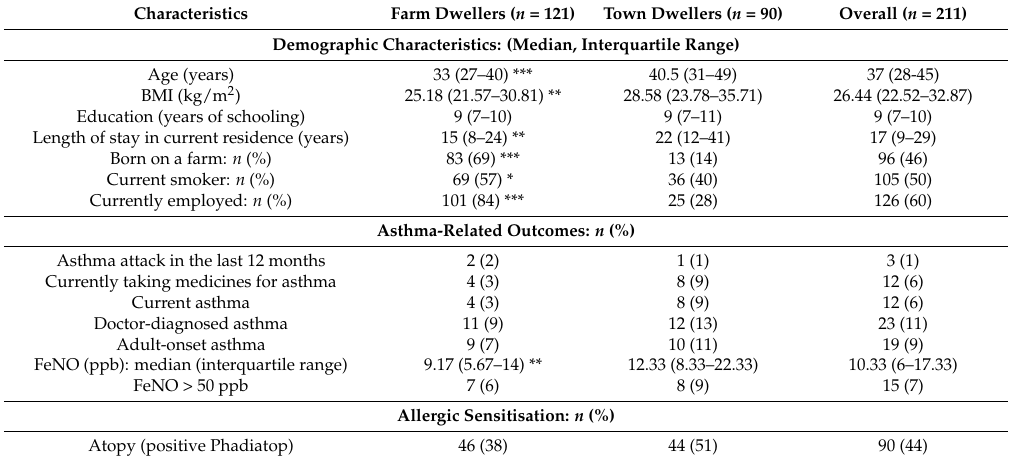
Table 1. Demographic characteristics, allergic, and asthma outcomes among rural women ( n =